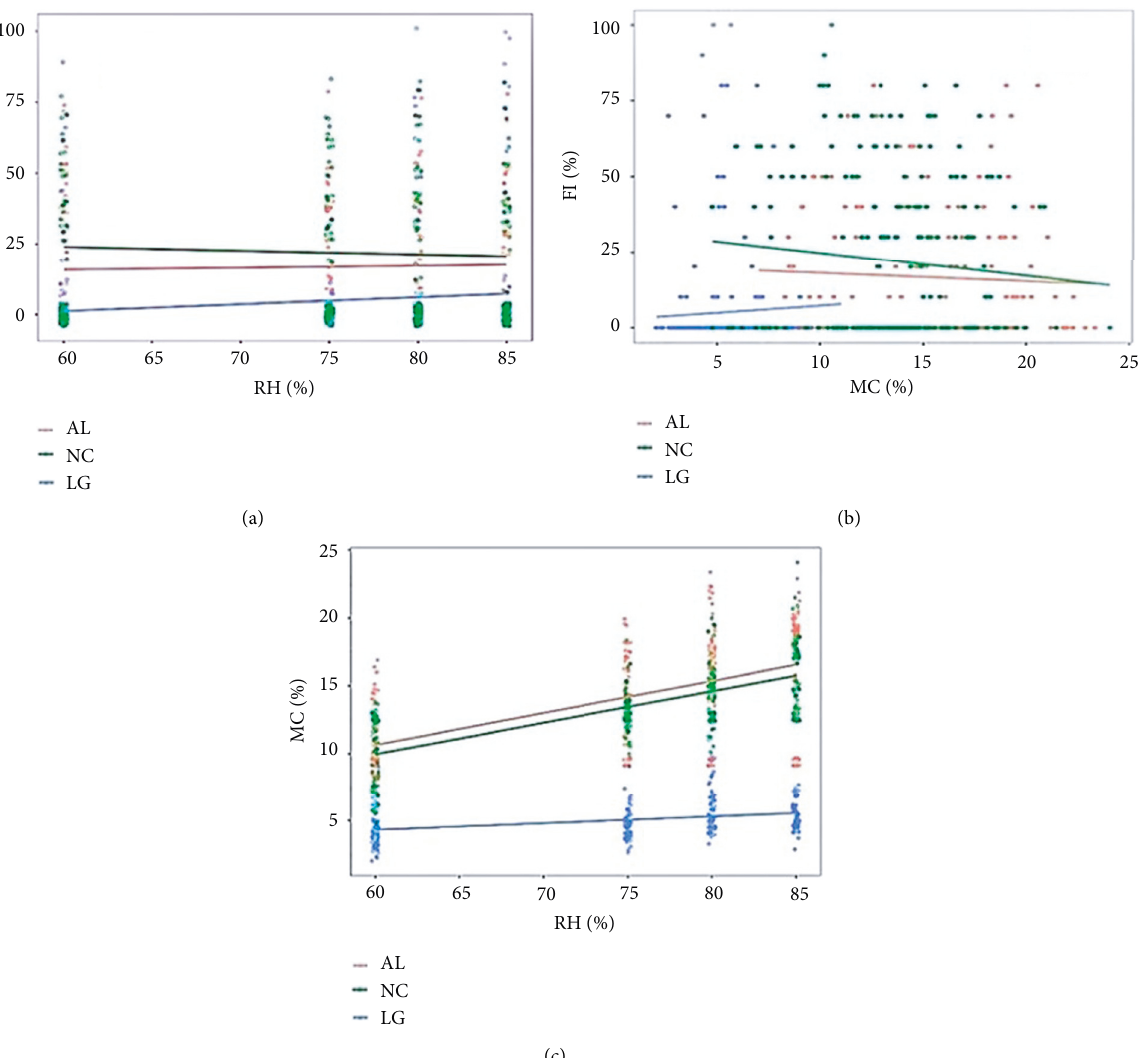
Figure 5: Correlation of the variables and seed types under study. (a) Correlation of FI and RH; (b) correlation of FI and seed MC; (c) correlation of seeds MC and RH; AL � A. lechuguilla , LG � L. graveolens , and NC � N. cespitifera